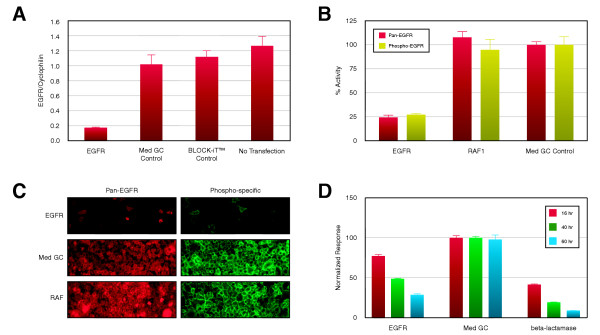
Knockdown by RNAi qualifies EGFR involvement in ME180 AP-1 CellSensor pathway. AP-1-bla ME180 cells transfected with RNAi targeting EGFR were analyzed by RT-qPCR (Panel A). EGFR mRNA expression is knocked down ~80% as compared to a non-specific control (Med GC). Results are represented as a ratio using cyclophilin as a control. Cells RNAi treated with oligos specific for EGFR show a reduced level of EGFR protein on the cell surface including a loss of autophosphorylation (Panels B and C). RFU represent measurement of the Alexa fluor 488 and 594 labelled secondary antibodies used for detection of the phospho and pan EGFR antibodies and represent the mean of (± SEM) eight independent data points (n = 8). RNAi treated AP-1-bla ME180 cells also exhibit a knockdown of AP-1 activation when EGF stimulated and analyzed at different timepoints (Panel D). Normalized response represents the amount of AP-1 gene activation present when compared with a non-specific control (Med GC), and represent the mean of (± SEM) eight independent data points (n = 8).